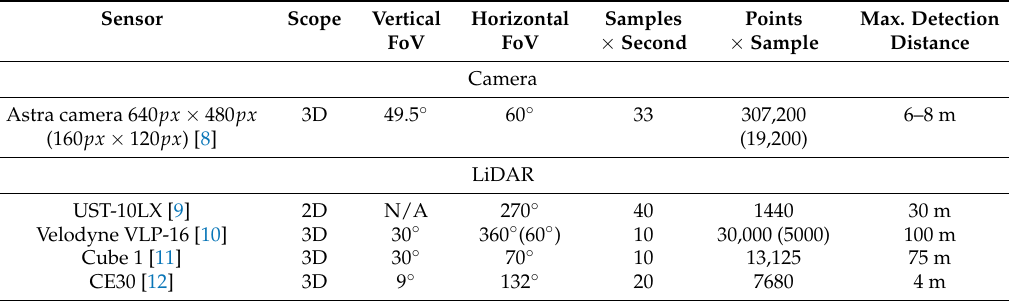
Table 1. Comparison of exemplary sensors used for perception by service